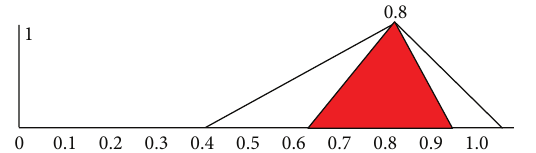
Figure 1: Two triangular fuzzy numbers (0.4, 0.8, 0.9) .